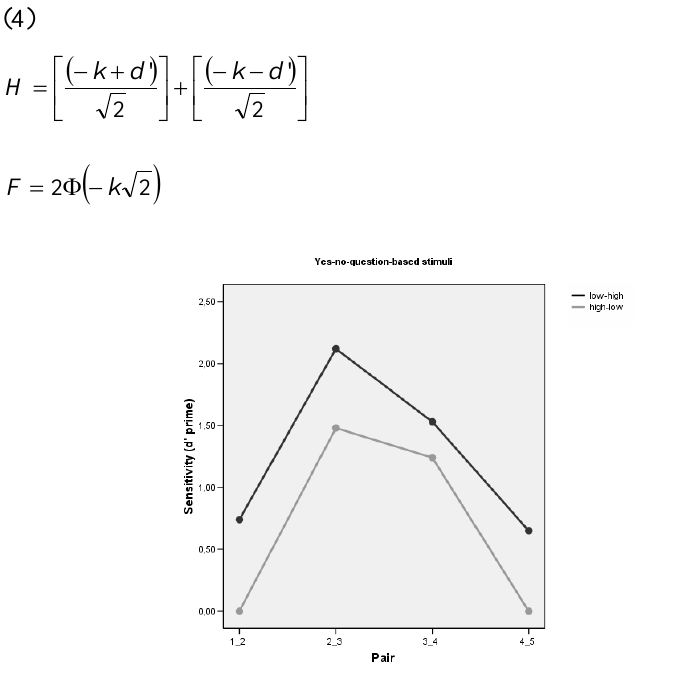
Figure 12. d' calculated for both orders of presentation of pairs from the continuum created from the yes-no question base stimulus.